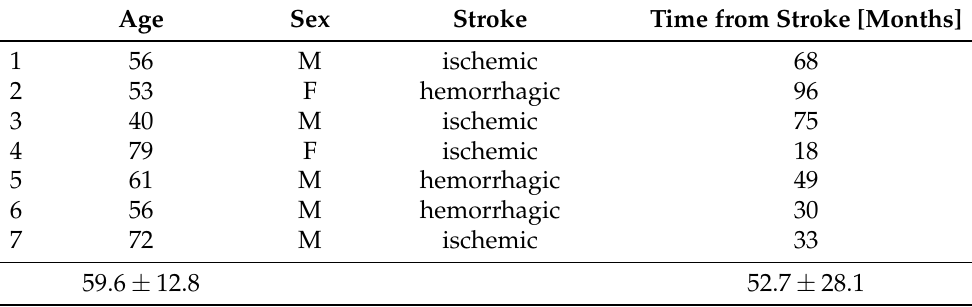
Table 1. Summary table of patients involved in this study.